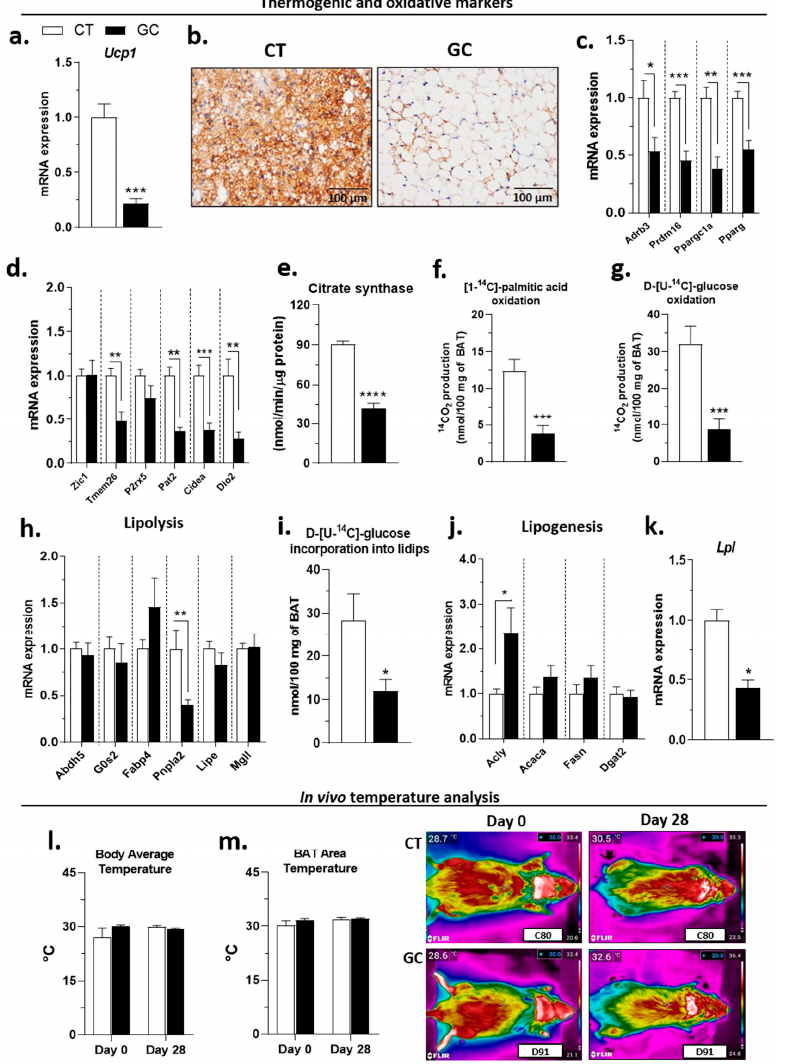
Figure 7. BAT gene and functional changes after chronic GC exposure. ( a ) Ucp1 gene expression; ( b ) UCP1 immunohistochemistry; ( c ) Ucp1 expression regulators— Adrb3, Prdm16, Ppargc1a , and Pparg ; ( d ) brown adipocytes markers— Zic1, Tmem26, Pat2, P2rx5, Cidea , and Dio2 ; ( e ) citrate syn- thase maximal activity; oxidation of ( f ) [1- 14 C]-palmitic acid and ( g ) D-[U- 14 C]- glucose; ( h ) lipolysis pathway genes— Abdh5, G0s2, Fabp4, Pnpla2, Lipe, and Mgll; (i) incorporation of D-[U-C 14 ]- glucose into lipids; ( j ) lipogenic pathway genes— Acly, Acaca, Fasn , and Dgat2 ; ( k ) Lpl expression; in vivo temperature analysis of ( l ) body and ( m ) BAT area on days 0 and 28 th of control (CT), and glucocor- ticoid-treated (GC) rats. ( b ) UCP1 staining: 100× magnification. Data are mean ± SEM of 8 (CT) and 8 (GC) samples ( a , c , d , h , j , k ), 8 (CT) and 9 (GC) samples ( e , f , g , i ), and 10 (CT) and 11 (GC) rats ( l , m ). * p < 0.05, ** p < 0.01, *** p < 0.001, and **** p < 0.0001 vs. CT (unpaired Student t -test; Mann–Whitney test in ( c )- Adrb3 and Ppargc1a ).